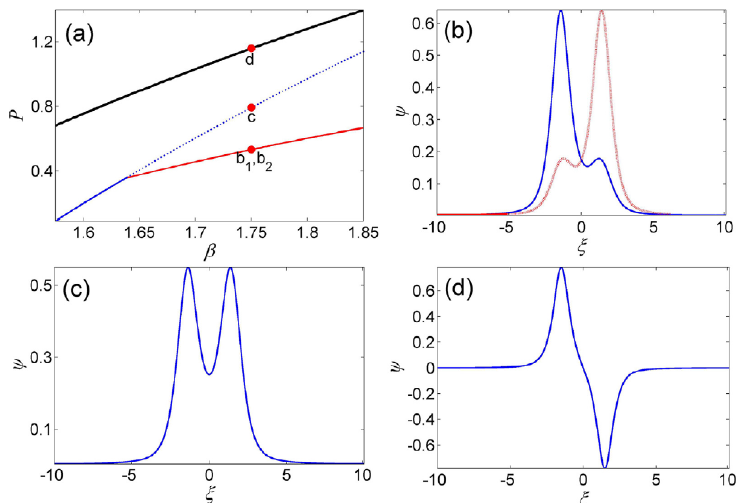
Figure 6. ( a ) Blue , red, and black lines show the norm (alias power, here denoted P ) of symmetric, asymmetric, and antisymmetric solitons vs. their propagations constants (denoted β ≡ − µ here) in the fractional system based on Equation (1) with g = 1 (the self-focusing nonlinearity) and the double-well potential (34). The solid and dotted segments of the blue line represent, respectively, stable and unstable subfamilies of symmetric solitons below and above the symmetry-breaking bifurcation. The branches of antisymmetric and asymmetric solitons are completely stable. Here and in Figures 7 and 8, the parameters of the potential (34) are V 0 = 1, w = 1.4, and x 0 = 1.5. Panels ( b – d ) display a pair of stable asymmetric solitons (mirror images of each other), an unstable symmetric soliton, and a stable anti-symmetric one, all taken at β = 1.75 (these solitons correspond to dots b 1,2 , c, and d in panel ( a )). Reprinted with permission from Reference [42]. Copyright 2020 Elsevier.